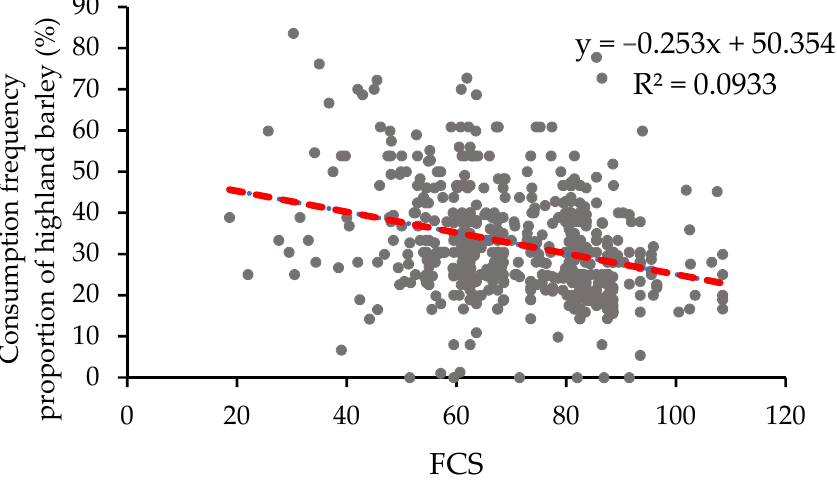
Figure 10. Relationship of the proportion of highland barley consumption frequency (%) and food consumption scores (FCS).